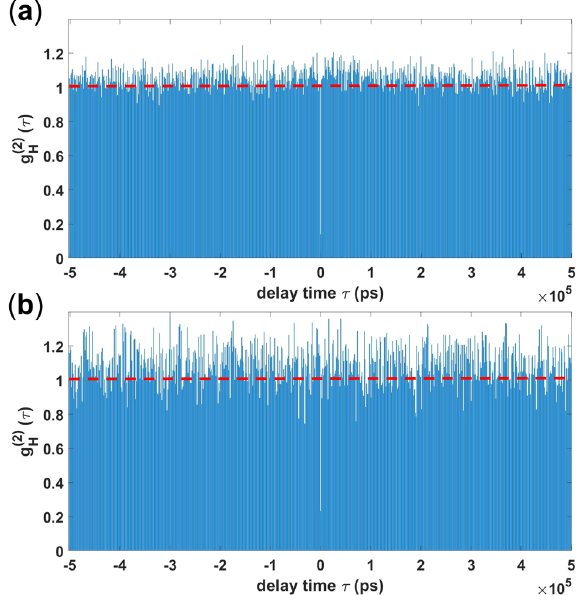
ðÞ . a Signal – signal and H